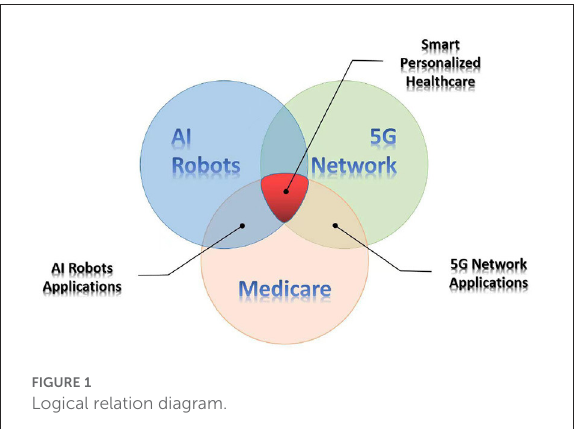
FIGURE1 Logical relation